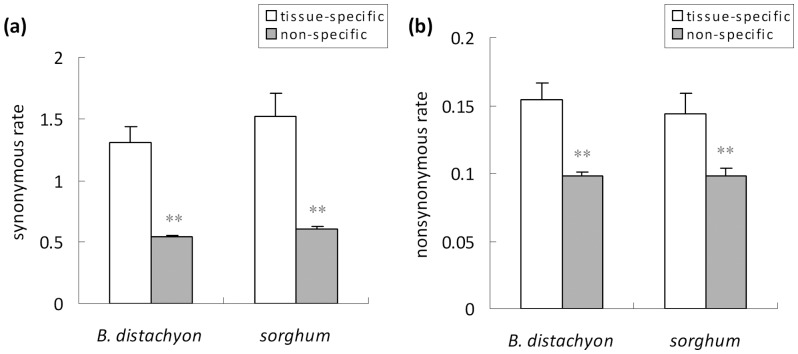
Comparison of synonymous d
S (a) and nonsynonymous substitution rates d
N (b) between rice and B. distachyon, and sorghum orthologous gene pairs for tissue-specific and non-tissue-specific classes of genes.The symbol ** indicates significant difference at the 0.01 level (p<0.01).